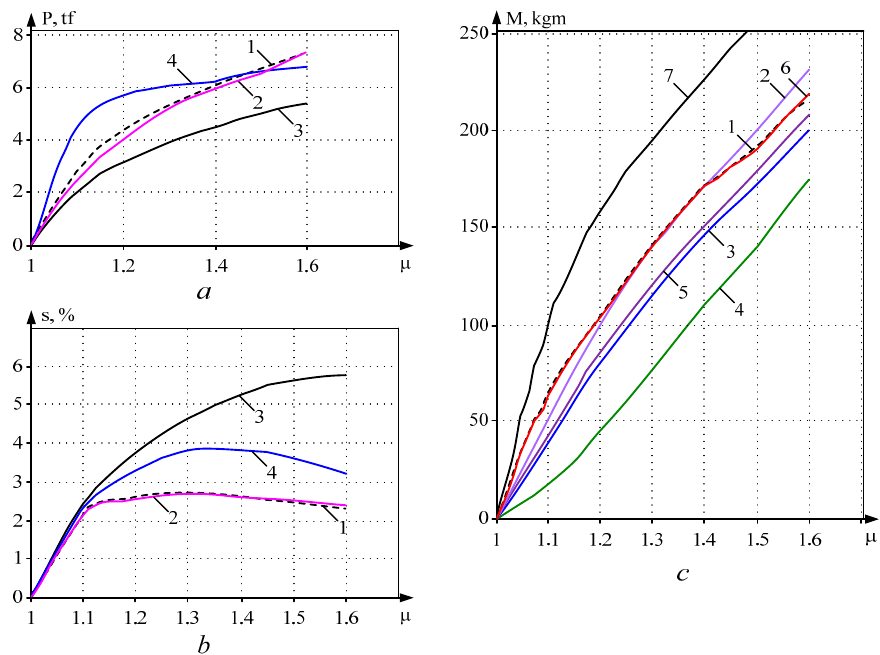
Figure 8. Calculated and experimental dependencies of pressure ( a ), flow ( b ) and torque ( c ) from the draw-down operation when rolling a wire rod with 11 mm diameter.